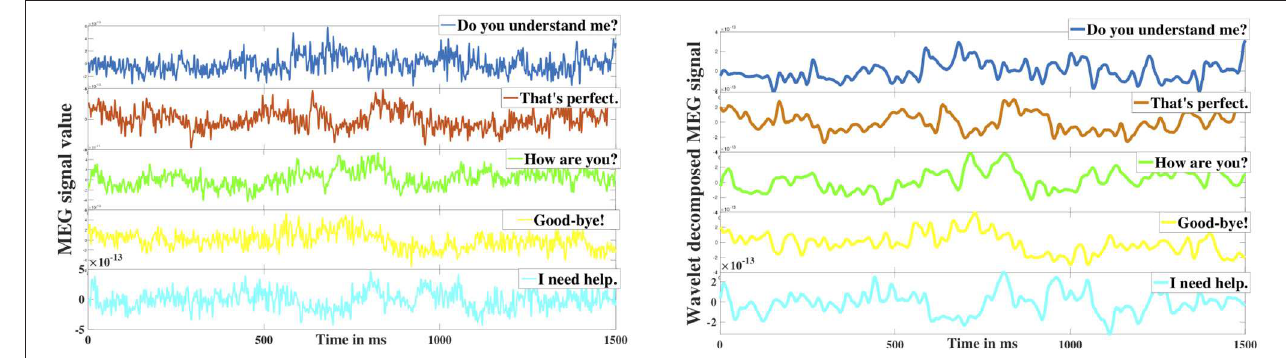
FIGURE 3 | Wavelet denoising. The left image represents the 5 raw MEG signals obtained from a sensor corresponding to the five different phrases. The right image represents the corresponding denoised